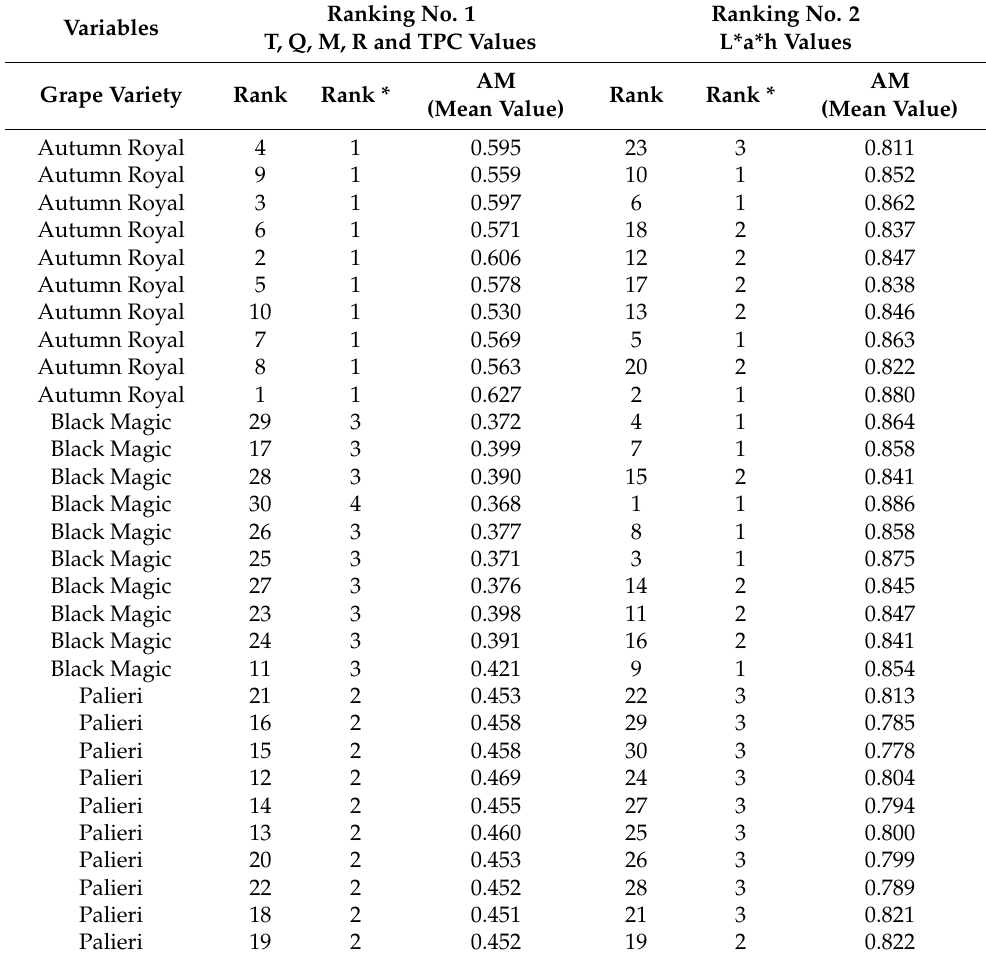
Table 4. Results of linear ordering analysis for the quality assessment of table grapes, based on two set of variables: Taxifolin (T), quercetin (Q), myricetin (M), rutin (R) and Total polyphenol content (TPC) as well as Lightness (L*), red (a*) and hue angle (h). AM—Aggregation measure. Ranking No. 1 Ranking No. 2 Variables T, Q, M, R and TPC Values L*a*h Values Grape Variety Rank